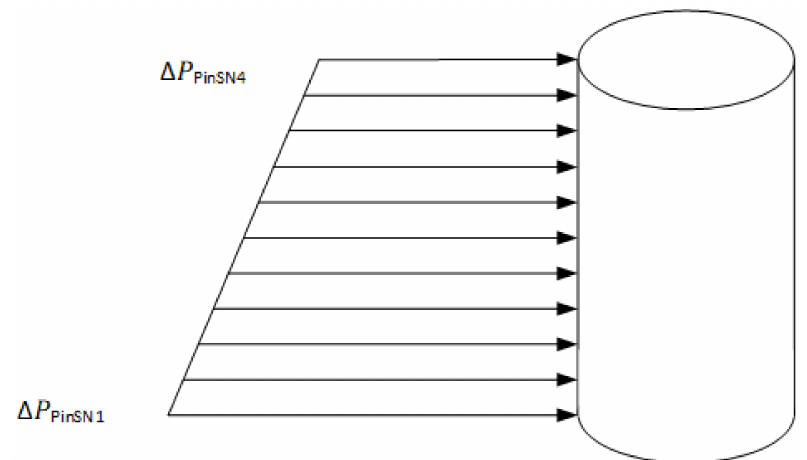
Figure 14. Linearly decreasing pressure profile on the core pin.